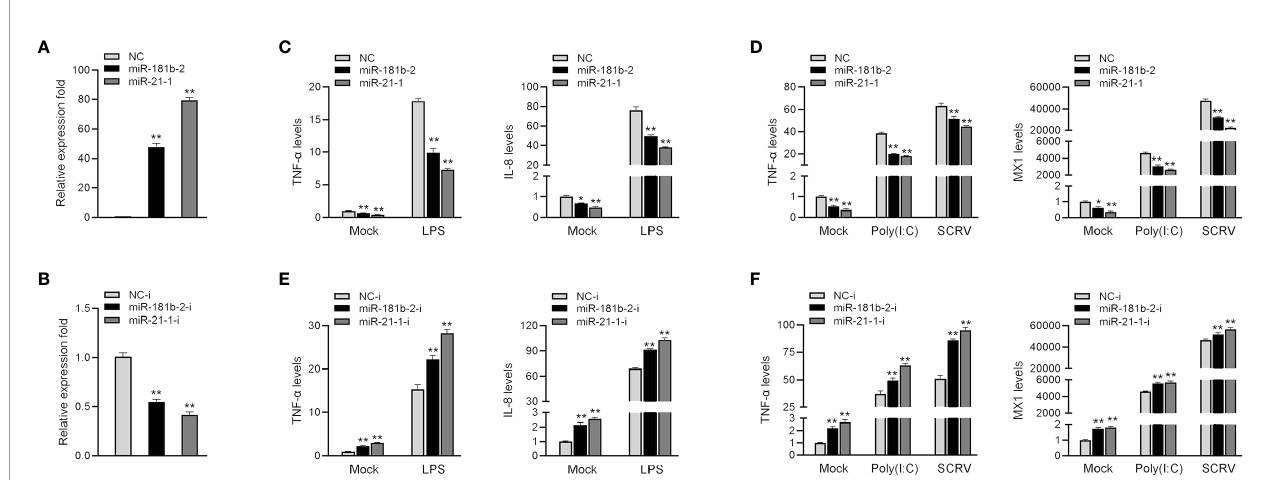
FIGURE 2 | MiR-181b-2 and miR-21-1 inhibit LPS, poly(I:C) or SCRV induce in fl ammatory response. (A, B) We transfected miR-21-1 and miR-181b-2 mimic (A) and miR-21-1 and miR-181b-2 inhibitors or NC, inhibitor NC into macrophage. (C, D) We transfected miR-21-1 and miR-181b-2 mimic into MBrC cells, and NC was used as a negative control. 24 h after transfection, the cells of the experimental group were stimulated with LPS, or poly (I:C) stimulation or SCRV injection, and then total RNA was extracted from the cells. The mRNA expression of TNF- a , IL-8 and Mx1 were detected by qRT-PCR. (E, F) miR-21-1 or miR-181b-2 inhibitors were transfected into MBrC cells, and inhibitor NC was used as a negative control. 24 h after transfection, the cells were stimulated with LPS, poly (I:C) and SCRV stimulation, total RNA was extracted by trizol. The mRNA expression of TNF- a , IL-8 and Mx1 were analyzed by qRT-PCR. All data are presented as the means ± SE from three independent triplicate experiments. ** p < 0.01, * p < 0.05 versus the controls.